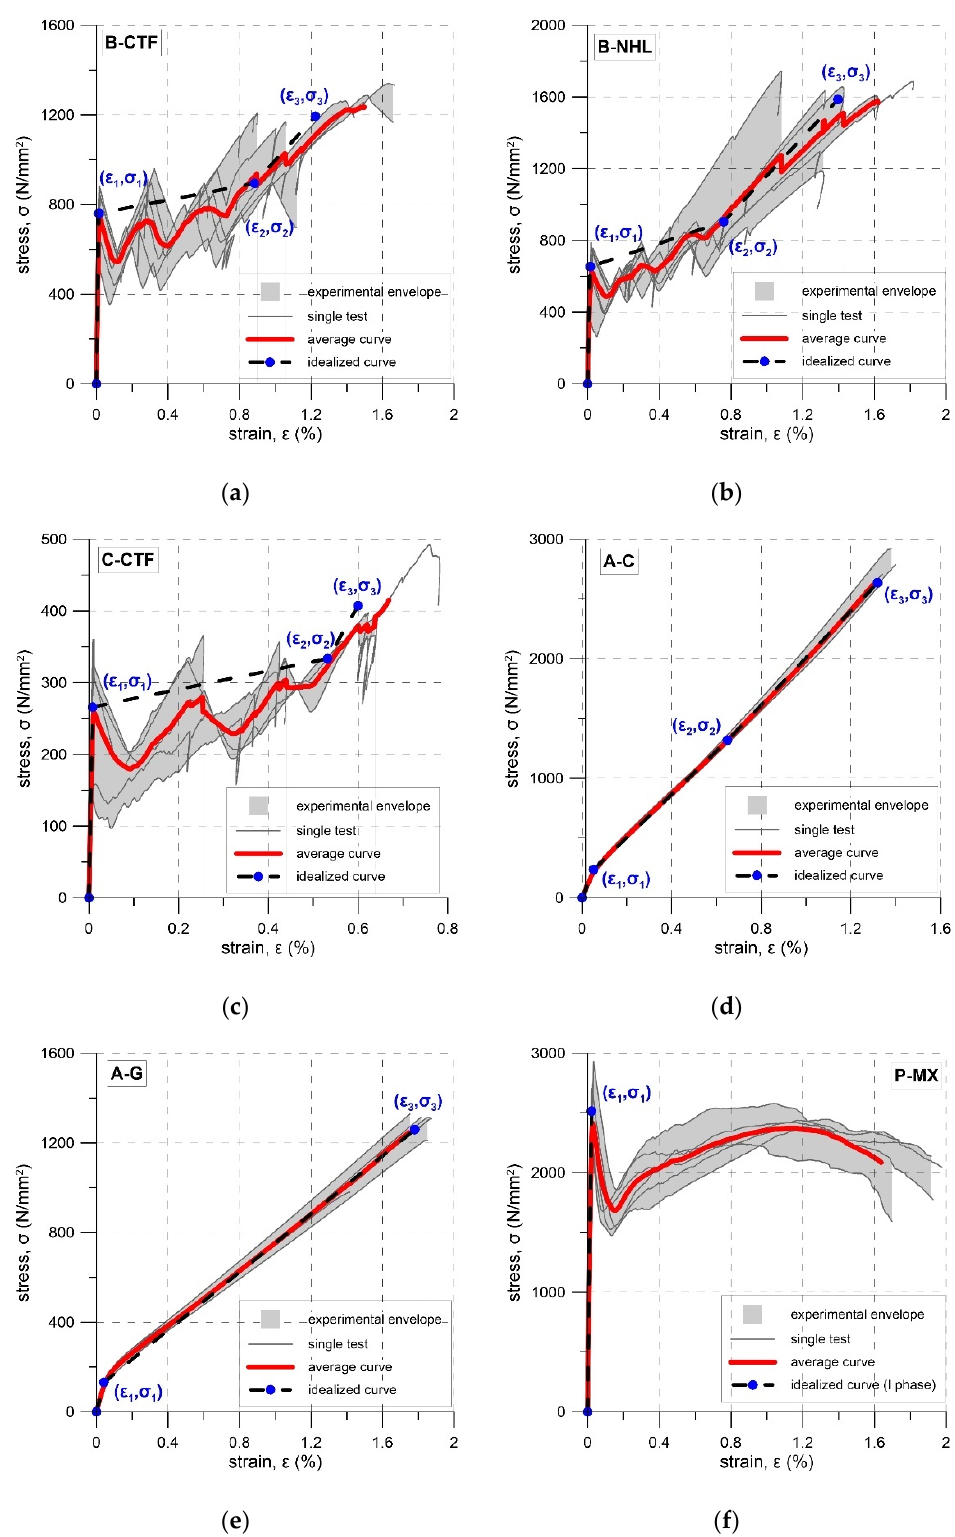
Figure 12. Idealised stress-strain curves: ( a ) B-CTF; ( b ) B-NHL; ( c ) C-CTF; ( d ) A-C; ( e ) A-G; ( f ) P-